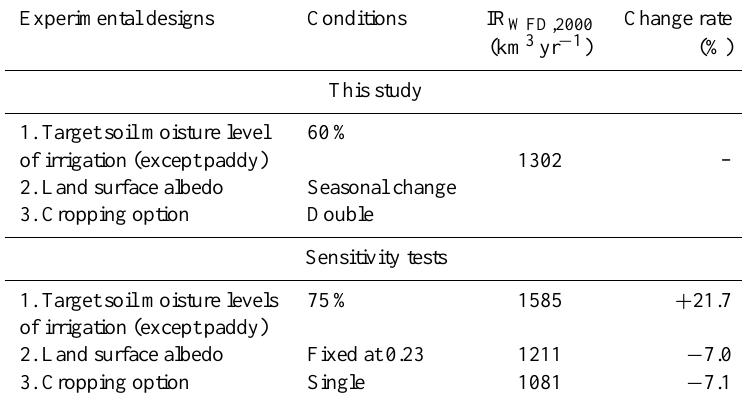
Table 3. Sensitivity study of the total global net irrigation water requirements in the year 2000 with regard to target soil moisture levels, surface albedo and